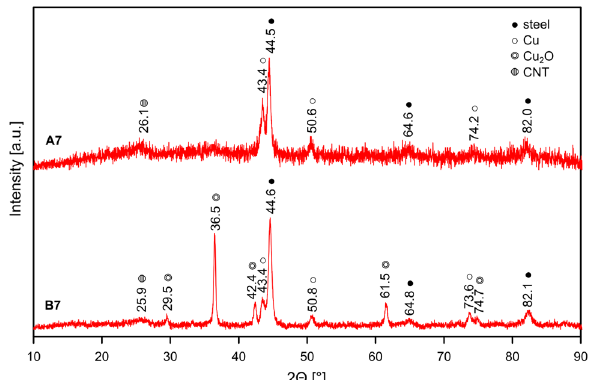
Figure 15. GIXRD patterns for A7 sample (ECD deposition time of 600 s, CuSO 4 concentration of 1 mM) and B7 sample (ECD deposition time of 600 s, CuSO 4 concentration of 100 mM).